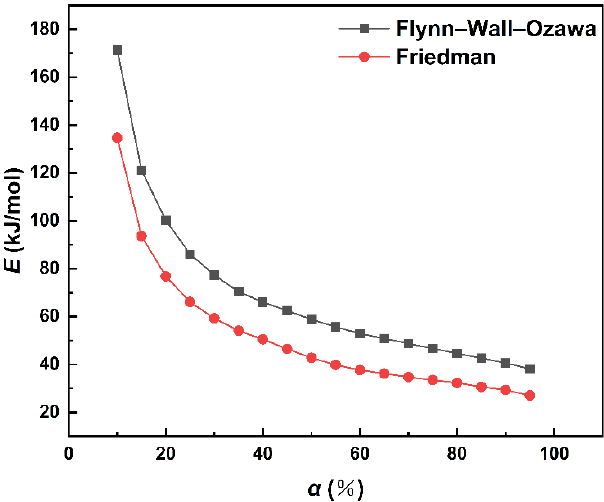
Figure 6. Dependence of the E a value on the curing degree.